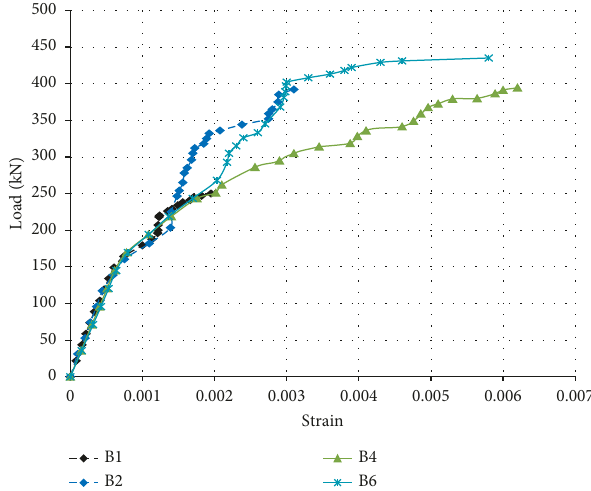
Figure 18: Load strain in concrete performances for models B1, B2, B4, and B6.